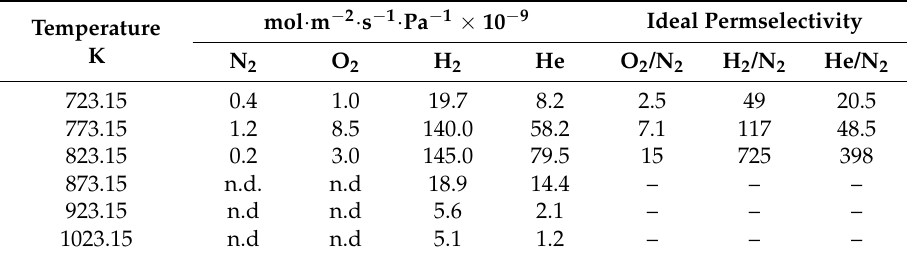
Table 2. c‐CMSM permeance to N 2 , O 2 , H 2 and He at 303.15 K and ideal permselectivities for c‐CMSMs carbonized at different temperatures after 1 day aging [51].